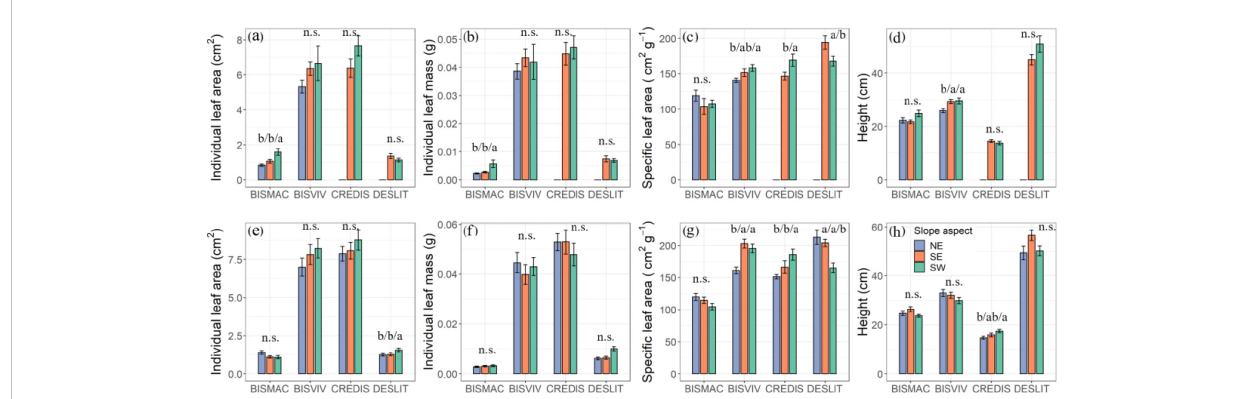
FIGURE 3 Effect of slope aspect on functional traits at mountain A (A – D) and mountain B (E – H) . NE, SE, and SW refer to northeast, southeast, and southwest slope aspect, respectively. Letters indicate signi fi cant differences (n.s., not signi fi cant). Values are mean ± SE. BISMAC, BISVIV, CREDIS, and DESLIT